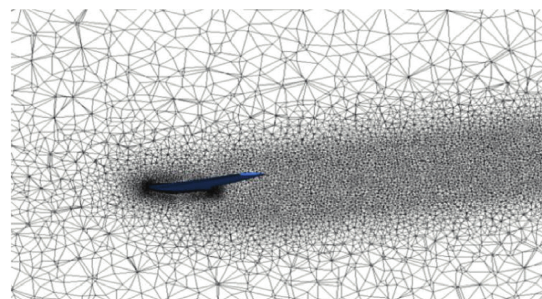
Figure 9: Detailed diagram of computational domain grid